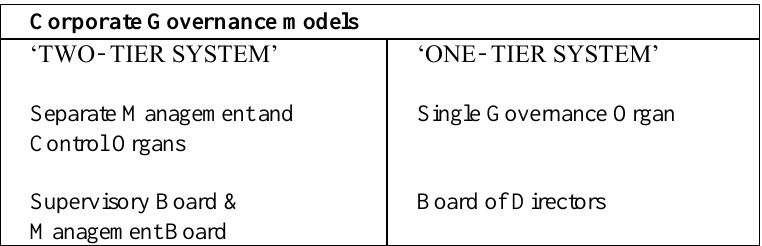
Figure 1: Corporate Governance